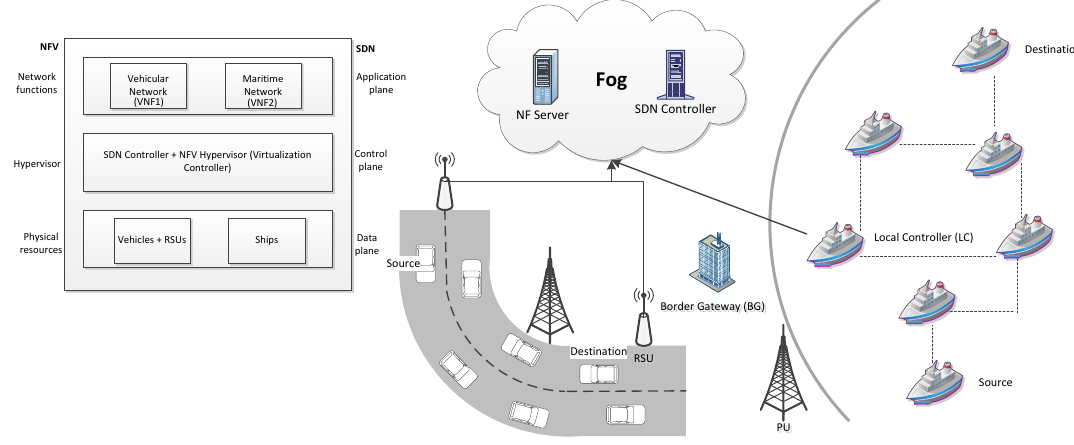
Figure 1. Integrated cognitive coastal